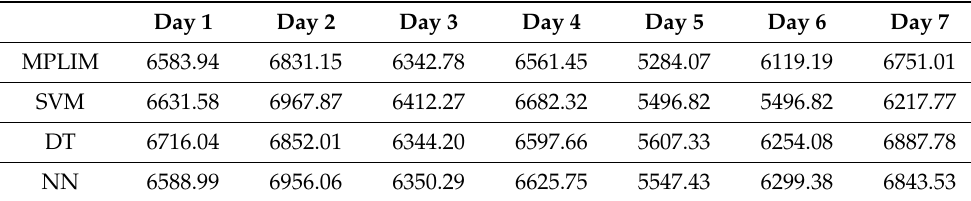
Table 5. Comparison of daily energy losses results in